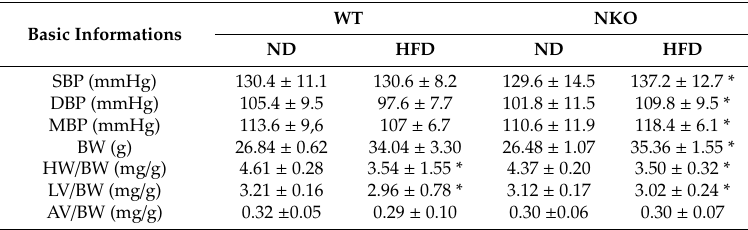
Table 2. Blood Pressure, Body Weight, and Tissue Weight Measurements.